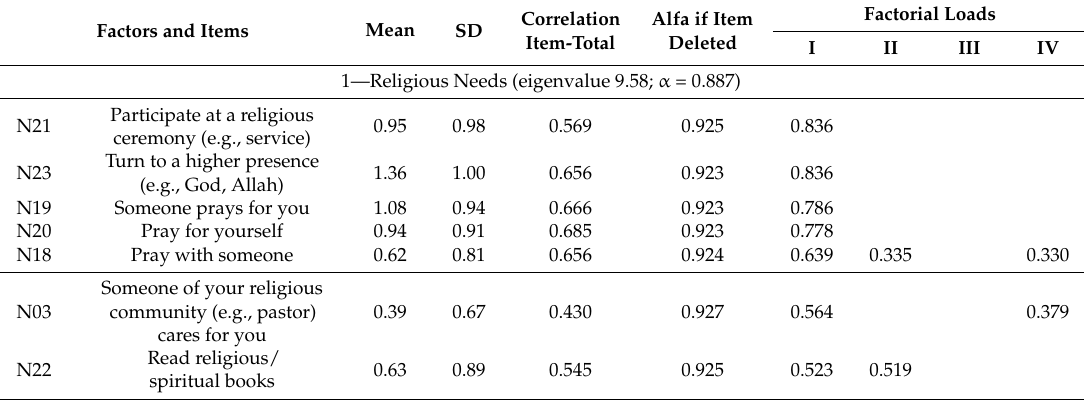
Figure 1. Graphical distribution of eigen values of Spiritual Needs Questionnaire —Portuguese Version (SpNQ-BR). Table 2. Factorial structure, means, standard deviations, correlation items and factorial loads of the 20 Spiritual Needs Questionnaire Portuguese Version (SpNQ-BR) in a four-factors structure.